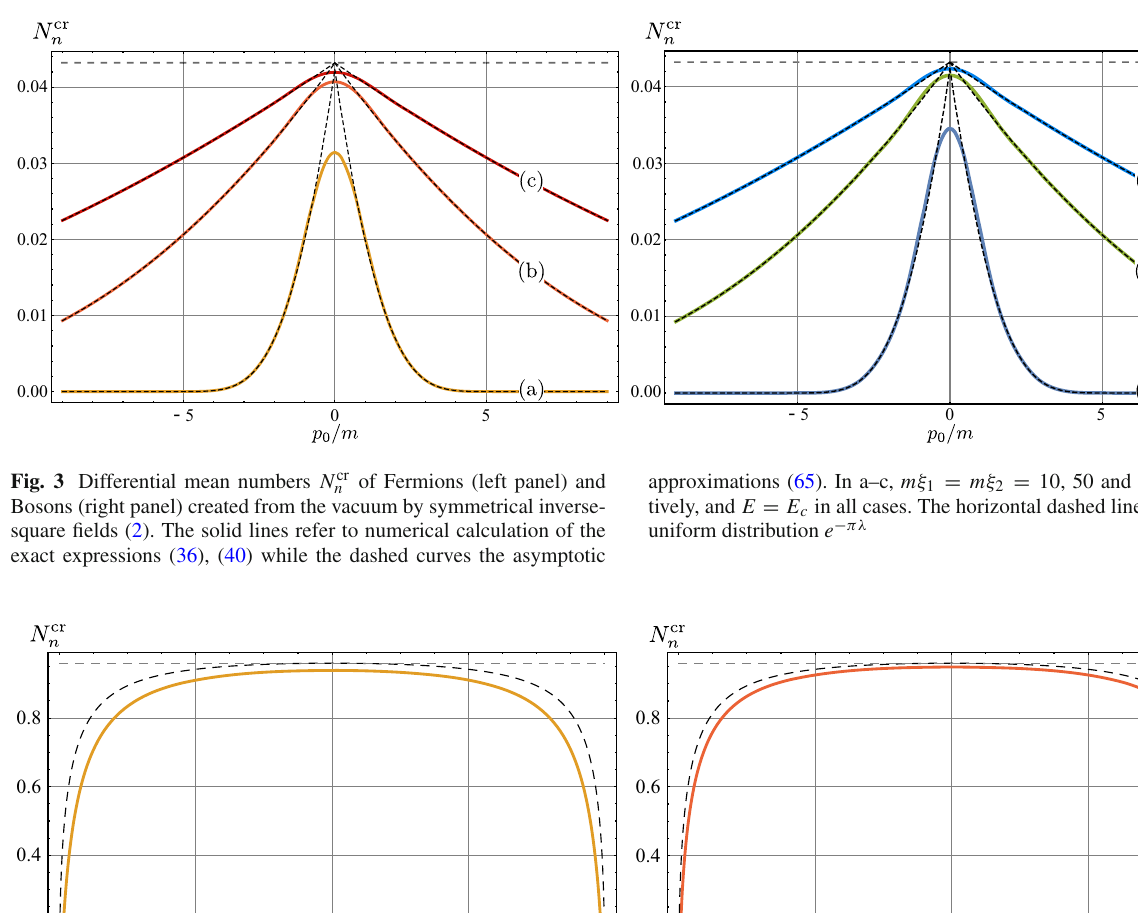
Fig. 4 Differential mean numbers of Fermions created from the vac- uum N cr n bysymmetricalinverse-squareelectricfields.Theexactresults (solid lines) are given by the absolute square value of Eq. (36) and the asymptotic ones (dashed curves), by Eq. (80). In the left panel, E = 250 E c and m ξ 1 = m ξ 2 = 1 / 50 while in the right panel,